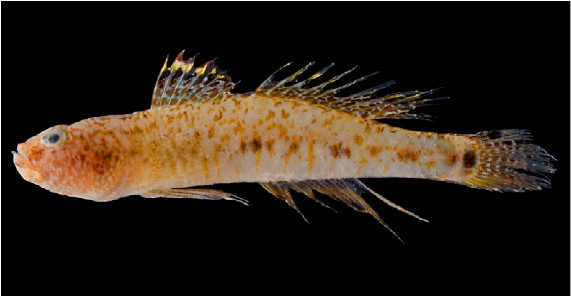
Figure 5. Favonigobius melanobranchus (Fowler, 1934), freshly col- lected specimen, PMR 2218 , male, 45.5 mm SL, Gulf of Suez (Photo S.V. Bogorodsky), (with permission of Bogorodsky, S.V., Kovačić, M. and J.E.